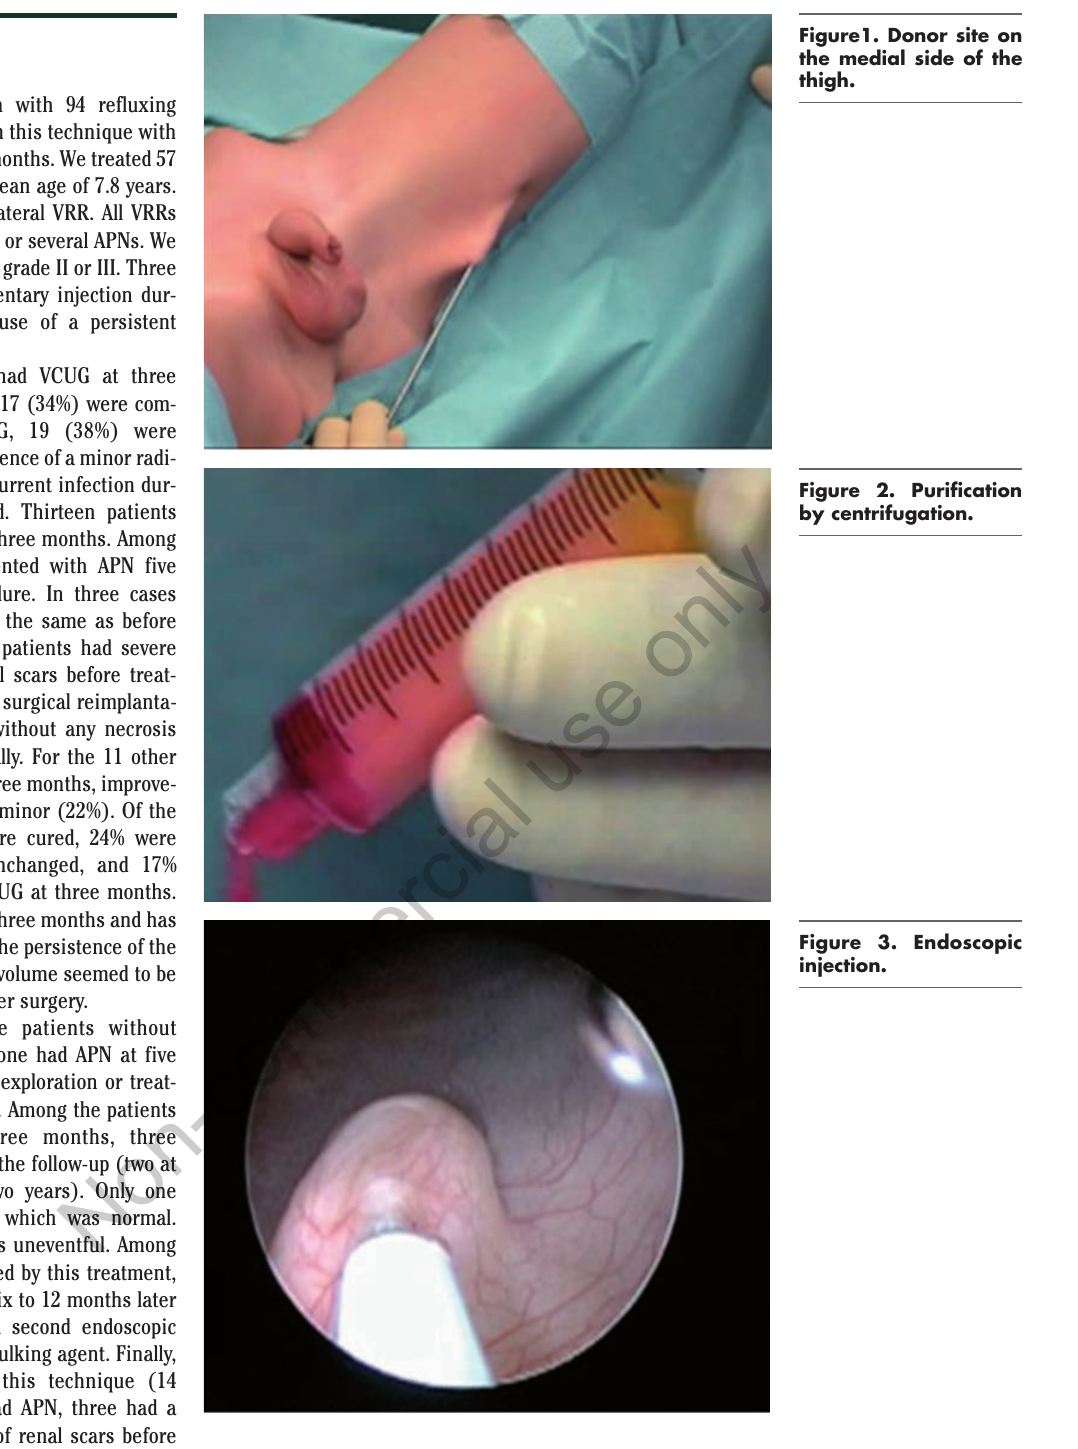
Figure1. Donor site on the medial side of the thigh.